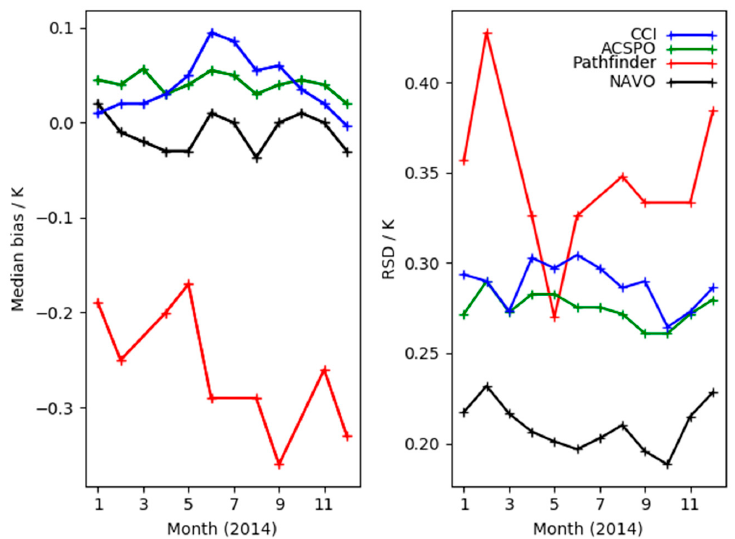
Figure 5. Left hand panel shows the monthly median difference between four different Sea Surface Temperature (SST) products when compared to the drifting buoy network and the right panel shows the robust standard deviation, an outlier robust estimate of the underlying standard deviation. The four products are from ESA CCI, Advanced Clear Sky Processor for Ocean (ACSPO—the NOAA operational AVHRR product), Pathfinder (from the NOAA Pathfinder SST product) and the Naval Oceanographic Office (NAVO—the US Navy SST product). All products used the same input AVHRR Level-1 data so are measuring exactly the same SST but due to algorithmic differences the products are not the